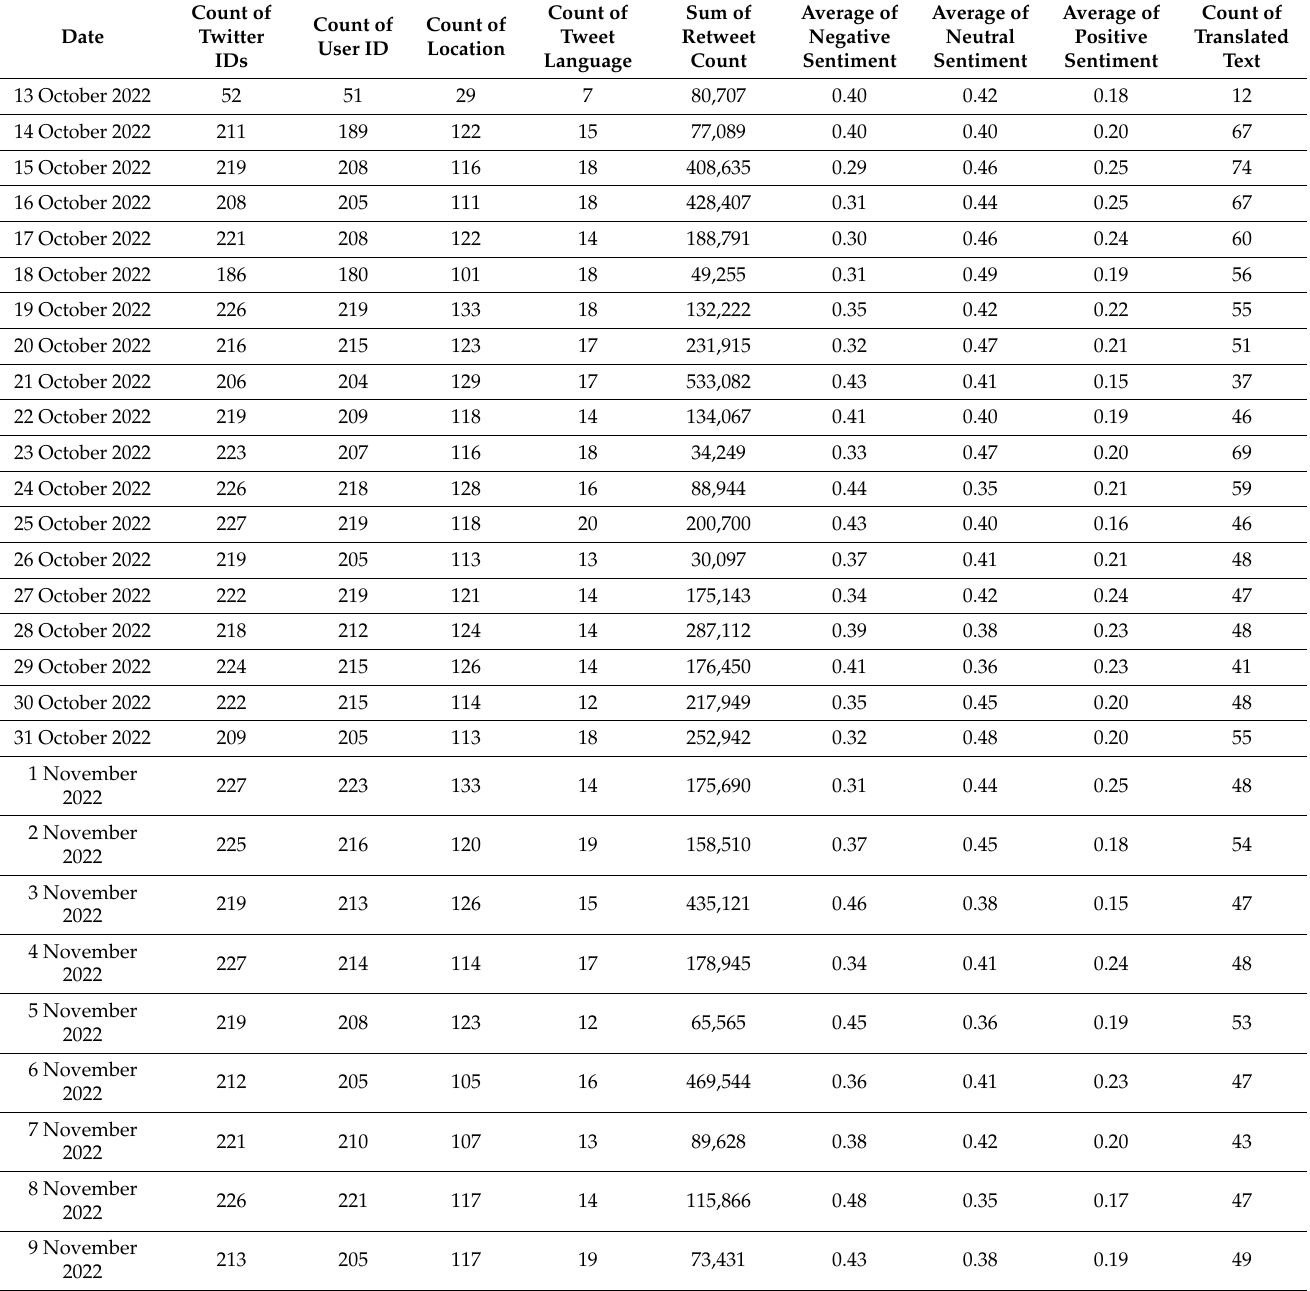
Table A1. Result of applying NLP algorithms on live Twitter data on a cyber-attack using the LCNC